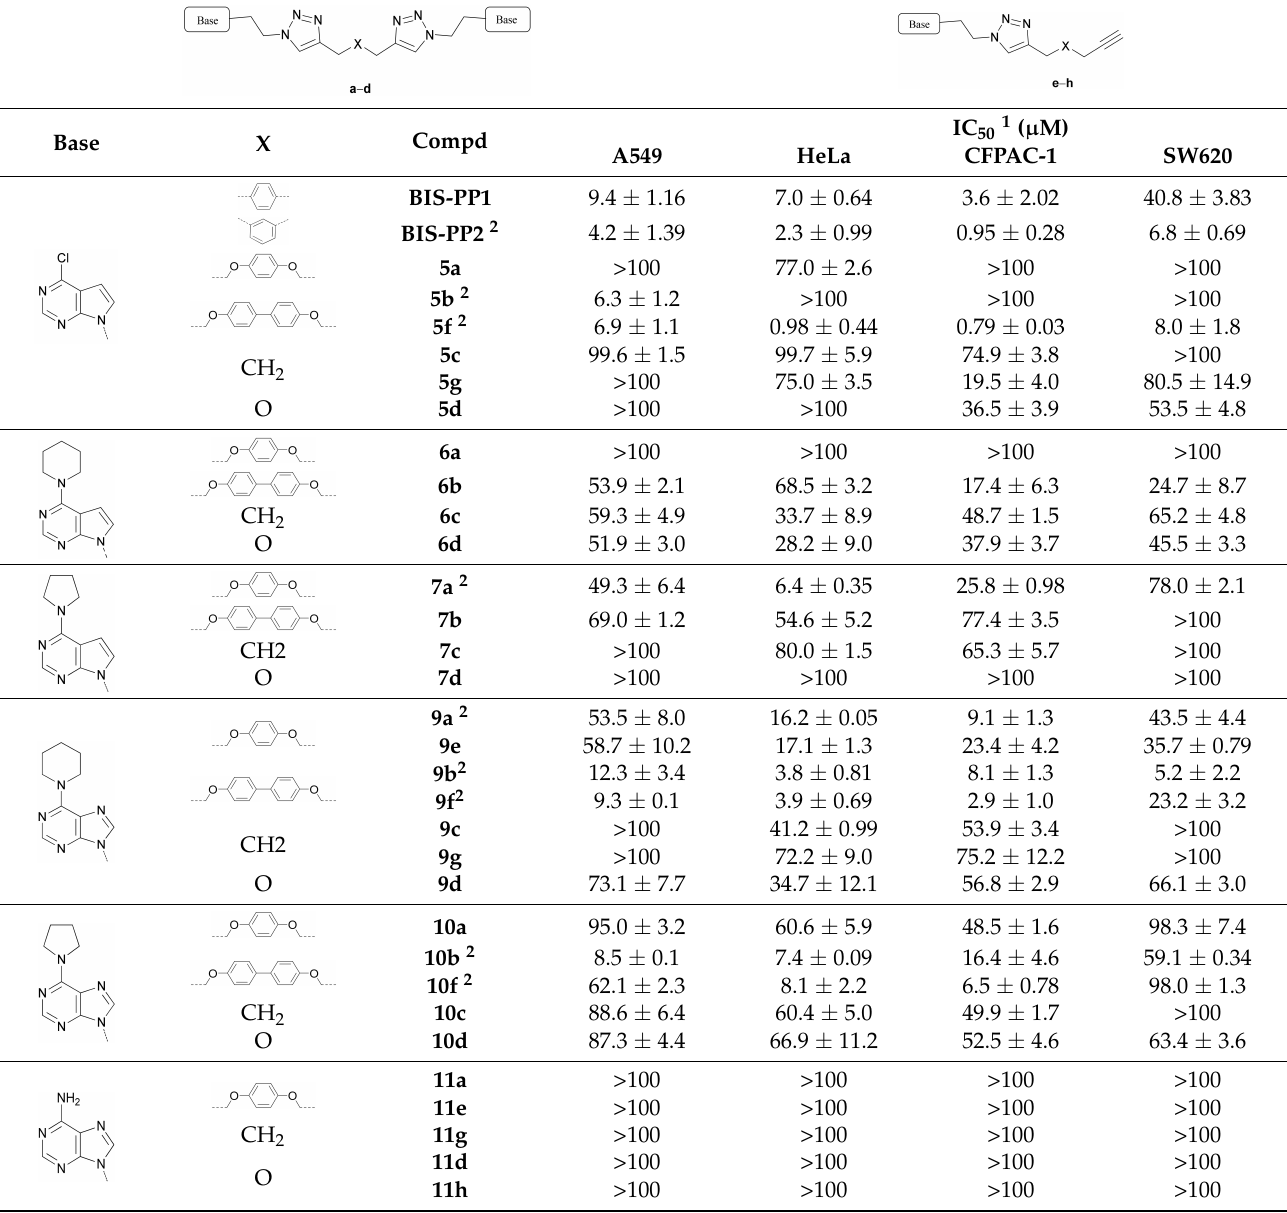
Table 2. Growth-inhibition effects in vitro of bis- and mono-pyrrolo[2,3-d]pyrimidine and purine derivatives on selected tumor cell lines and normal